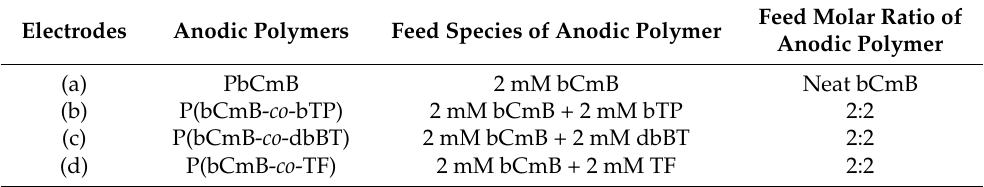
Table 1. Feed species of polymeric electrodes.